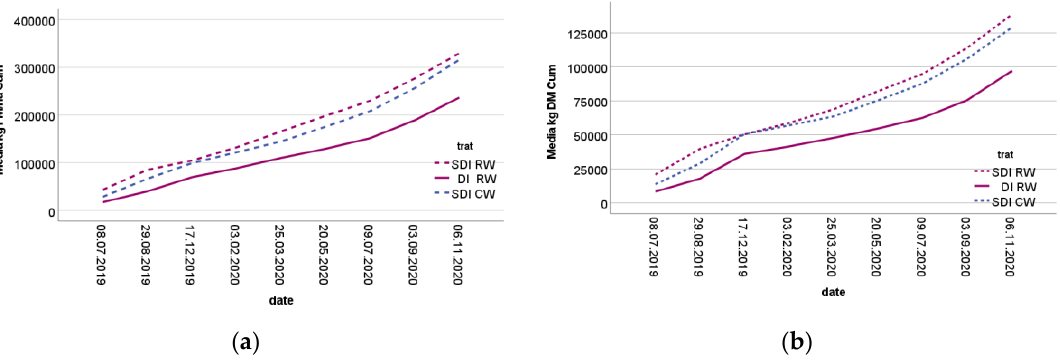
Figure 4. Accumulated yield, expressed as kg fresh matter (FM) · ha − 1 ( a ) and dry matter (DM) · ha − 1 ( b ) obtained when irrigating by subsurface drip irrigation and drip irrigation utilizing reclaimed water (SDIRW and DI RW, respectively) and SDI using conventional water (SDI